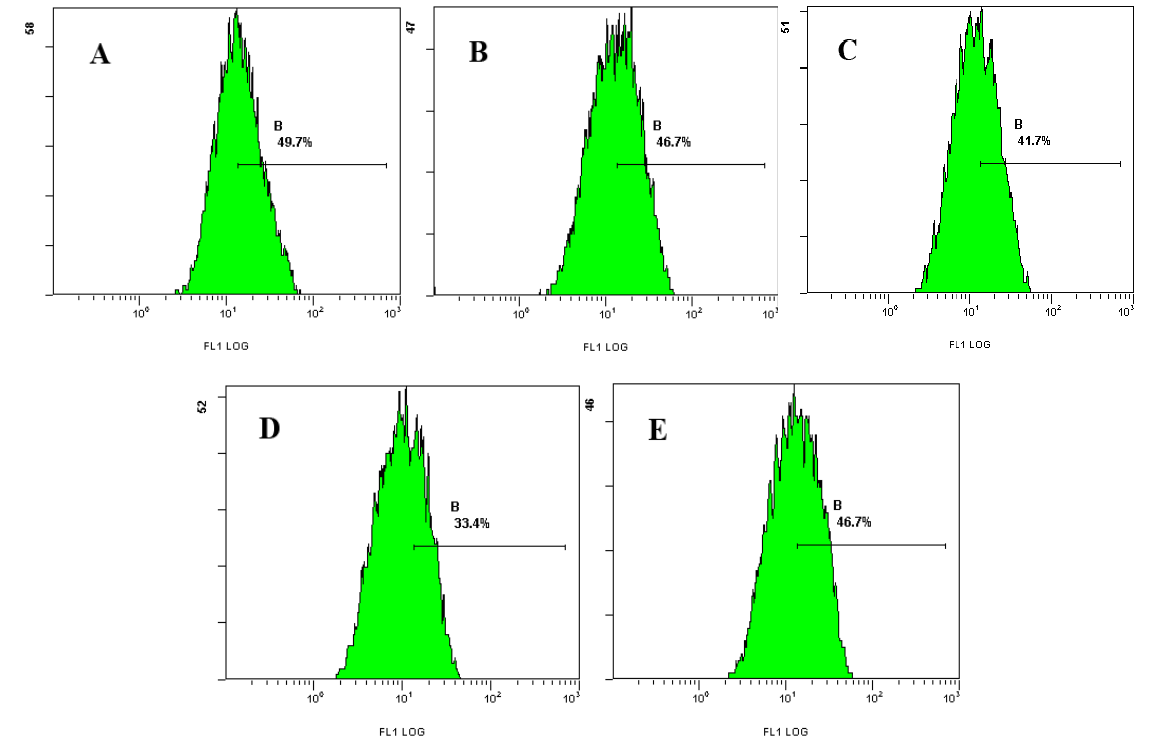
Figure 5. Effect of laminarin on pH of LOVO cells by FCM analysis. ( A ) Cells were treated as control group; ( B ) Cells were treated with 400 µg · mL − 1 laminarin; ( C ) Cells were treated with 800 µg · mL − 1 laminarin; ( D ) Cells were treated with 1,600 µg · mL − 1 laminarin; ( E ) Cells were treated with 5 µg · mL − 1